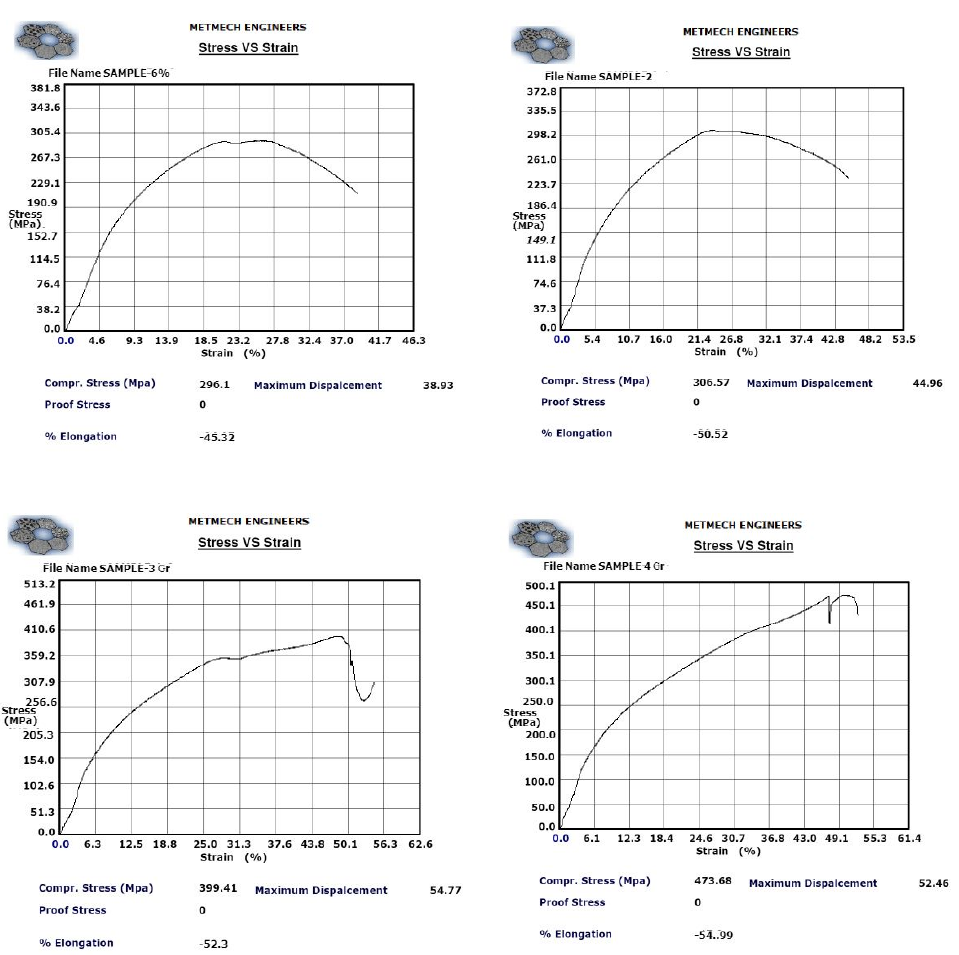
Figure 16. Sample stress-strain curves of compression test Fig 16 Sample Stress-Strain Curves of Compression Test Specimens